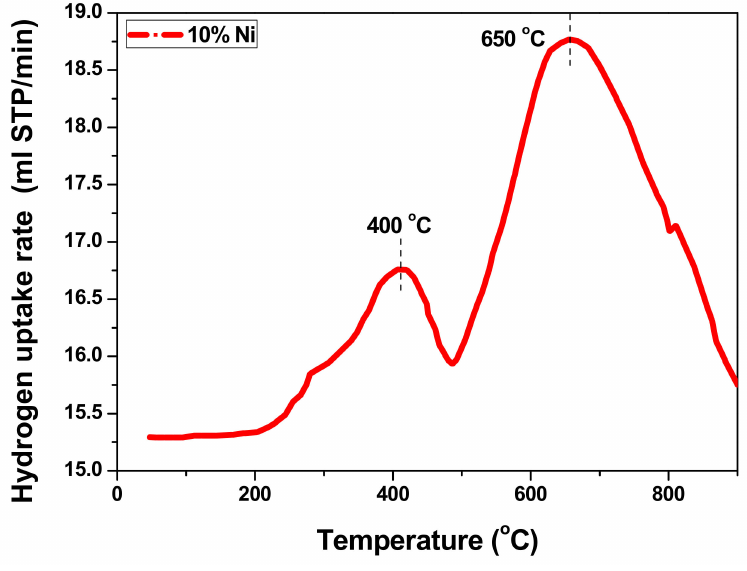
Figure 3. Temperature-Programmed Reduction (TPR) of 10%Ni/Al 2 O 3